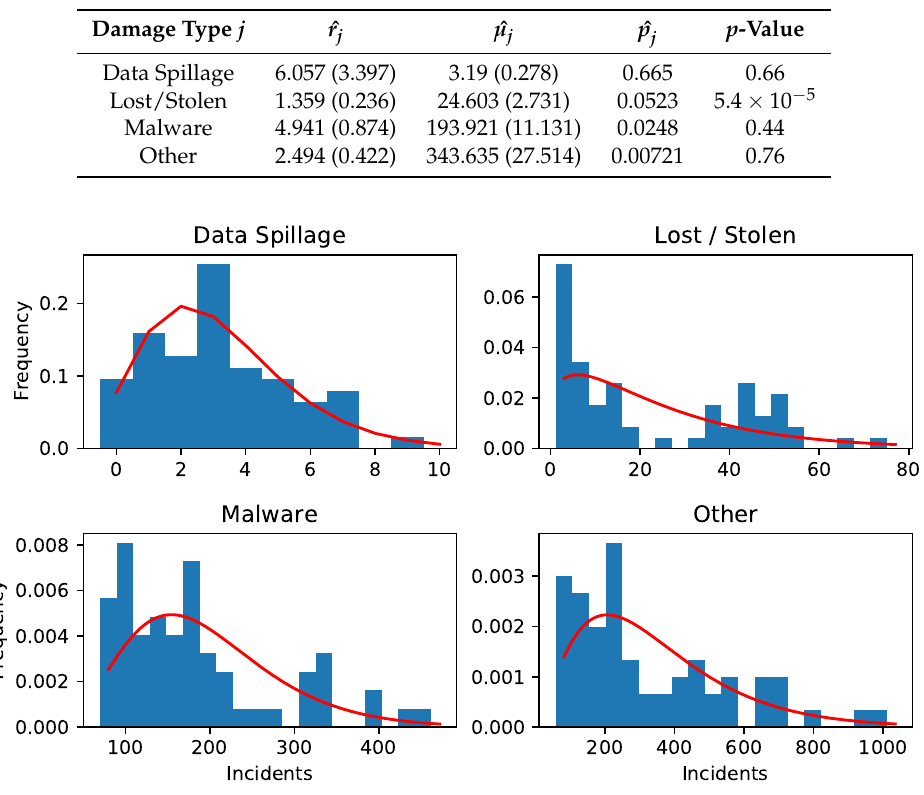
Figure 4. Histograms of observed counts for each category of damage with the PMF of the fitted Negative Binomial distribution overlaid in red (with lines between each point of the discrete